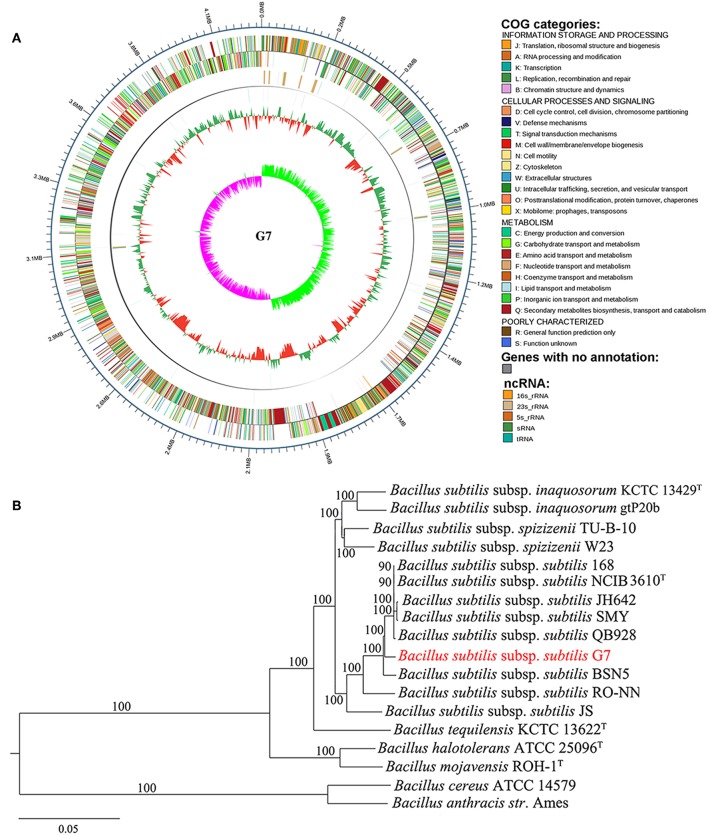
Circle genome map (A) and core genome phylogeny (B) of G7. (A) The scale on the outside of the circles indicates the size of G7 genome; the chromosome is represented by circles ranging from 1 (outer) to 4 (inner). Circle 1, the genes annotated by COG database (indicated by colors other than gray) and genes with no annotation (indicated by gray color); Circle 2, ncRNA, with colors indicating different types of ncRNA as shown in the figure; Circle 3, GC content; Circle 4, GC skew. (B) Neighbor-joining tree was constructed based on 1,113 highly conserved orthologous genes of 18 annotated genomes of Bacillus. Each node number represents the percentage of bootstrap support from 1,000 resampled datasets. The scale bar represents 0.05 substitutions per site.